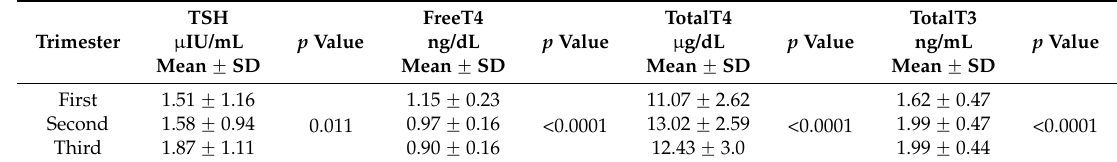
Table 2. The mean values of thyroid function test parameters per each trimester.